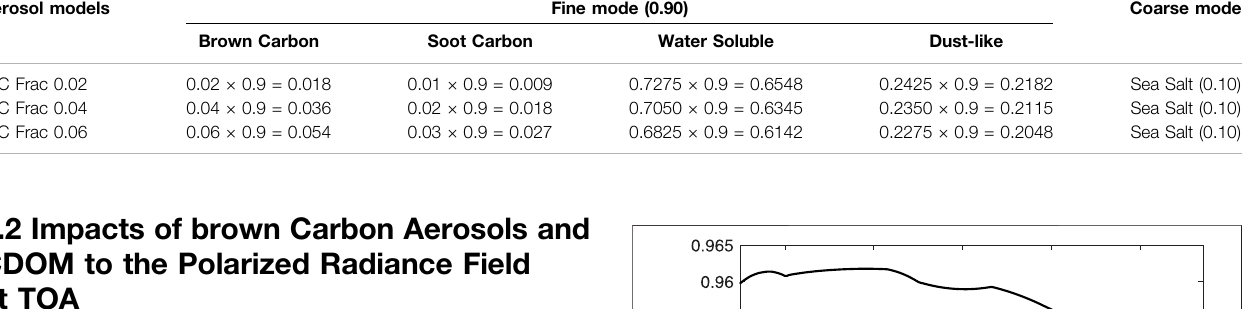
TABLE 1 | The volume fractions of different components for the aerosol models used in the study. Aerosol models Fine mode (0.90)